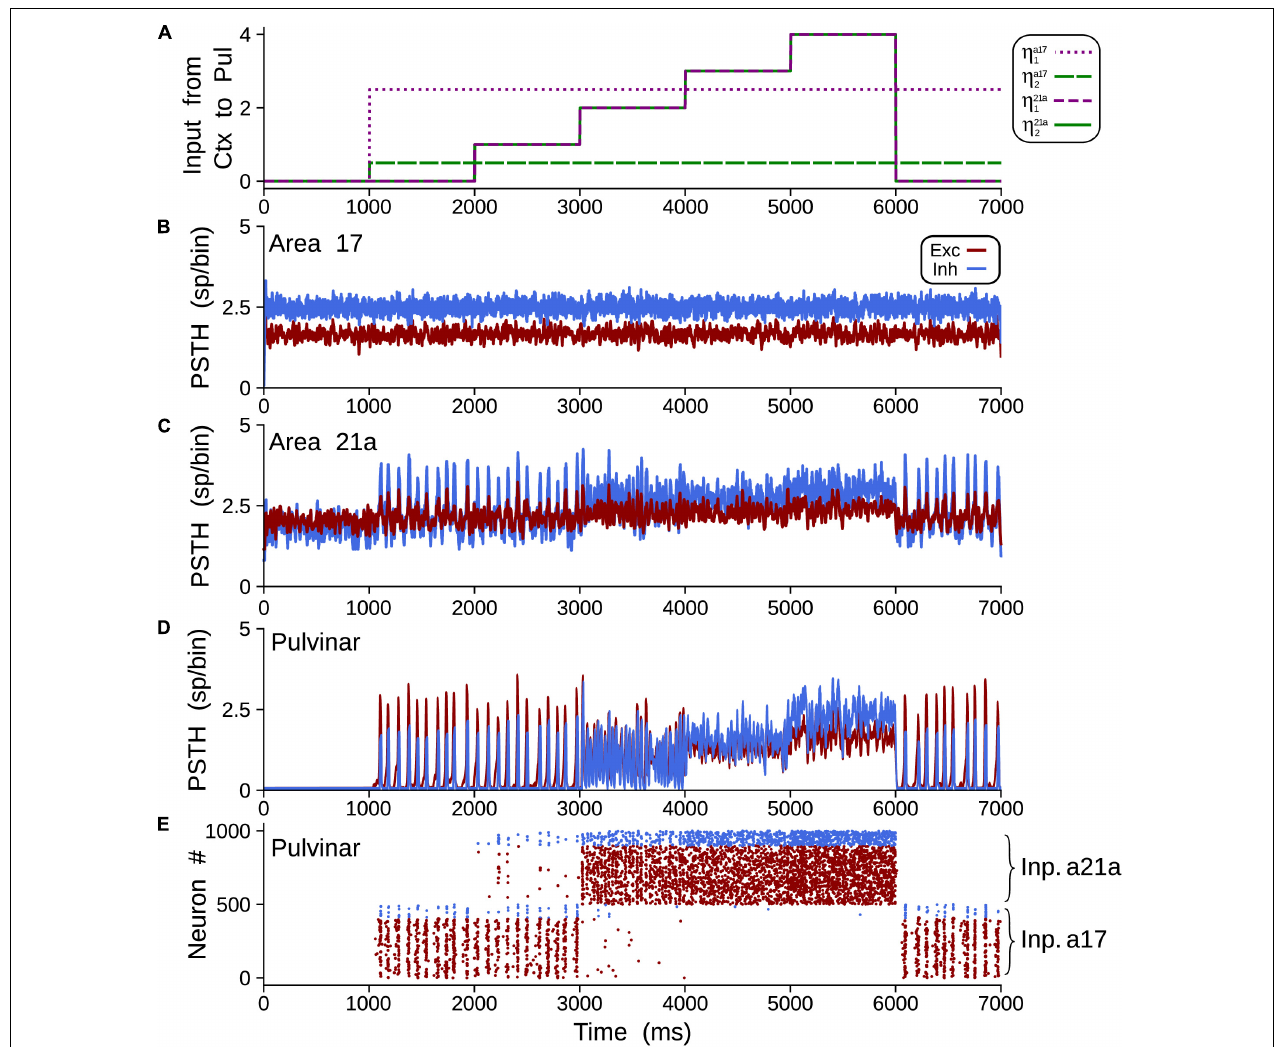
FIGURE 11 | Example of oscillatory alpha-band activity transmission by transthalamic network for a network as Figure 2A3 . (A) Weights of connections, η a 17 , 21 a 1 and η a 17 , 21 a 2 for areas 17 and 21a. PSTH for areas 17 (B) , 21a (C) and pulvinar (D) . (E) Raster plots for neurons in the pulvinar. Note that half of the pulvinar neurons are targeted by CT projections from area 17 and the other from area